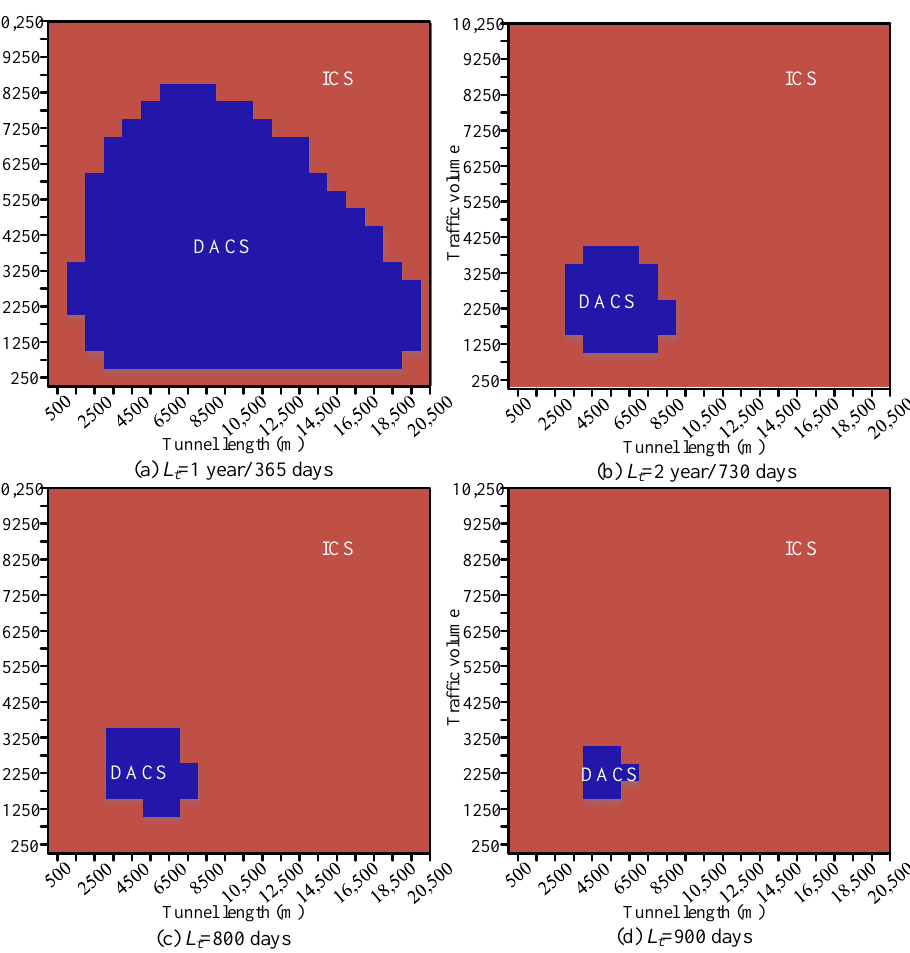
Figure 10. Choice of the control strategy for tunnels with different traffic volumes and lengths.